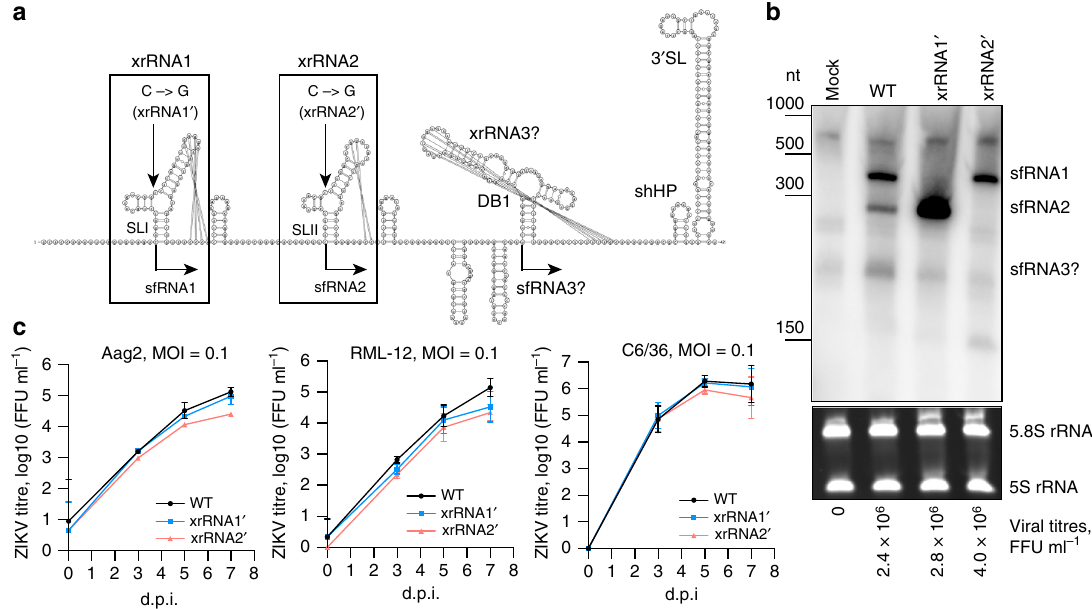
Fig. 1 Analysis of sfRNA-de fi cient ZIKV mutants in cultured mosquito cells. a Model of ZIKV 3 ʹ UTR secondary structure and location of mutations that impair sfRNA production. The model was created using the mfold algorithm, re fi ned based on the crystal structure of xrRNA1 ʹ and visualised with VIENNA RNA software. Mutation in xrRNA1 was described previously and is based on RNA crystal structure 11 , mutation in xrRNA2 was designed based on homology between xrRNAs. SL, stem loop; DB, dumb bell; shHP, small hairpin; xrRNA, XRN-1-resistant RNA. b Production of sfRNAs by WT and mutant viruses in C6/36 cells. Cells were infected at MOI = 1, RNA was isolated at 3 dpi and used for Northern blot hybridization with radioactively labelled DNA oligo complementary to the viral 3 ʹ UTR. Bottom panel shows Et-Br-stained ribosomal RNA as a loading control. Viral titres shown below the panels were determined in culture fl uids of the infected cells prior to RNA extraction from cells. c Growth kinetics of WT and sfRNA-de fi cient viruses in RNAi-de fi cient (C6/36) and RNAi-competent (RML-12 and Aag2) mosquito cell lines. Cells were infected at MOI = 0.1 and viral titres in culture fl uids were determined at indicated time points. Titres in ( b ) and ( c ) were determined using IPA on Vero cells. Values in ( c ) represent the means from three independent experiments ± SD. Statistical comparison between mutants and WT virus was performed using two-way ANOVA with Geisser-Greenhouse correction for multiple comparisons. Image in ( b ) is a representative blot of two independent experiments that produced similar